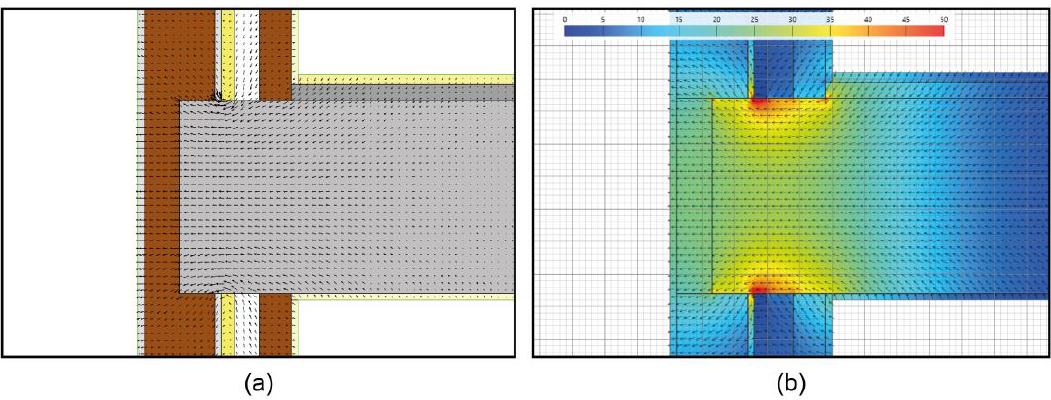
Figure 5. ( a ) Modelling of the thermal bridge of the slab front carried out using THERM and ( b ) Modelling of verification carried out using HTFlux.